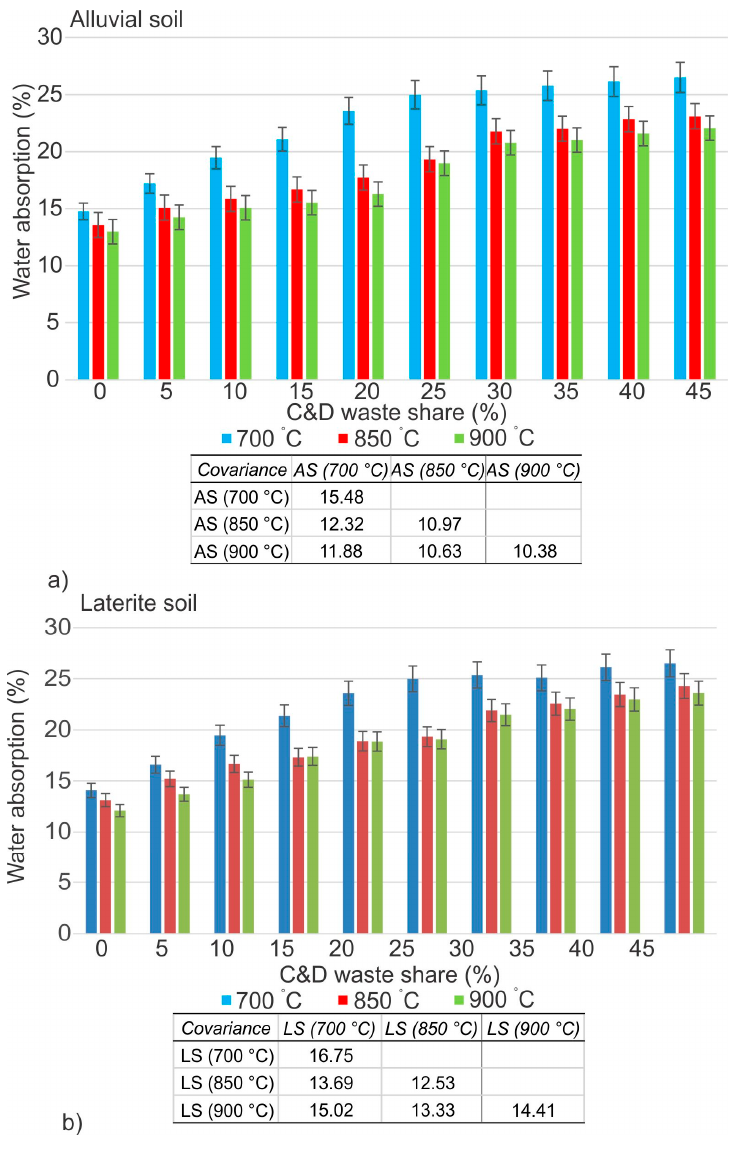
Figure 6. Water absorption of mixed C&D waste in alluvial ( a ) and laterite ( b ) soil.